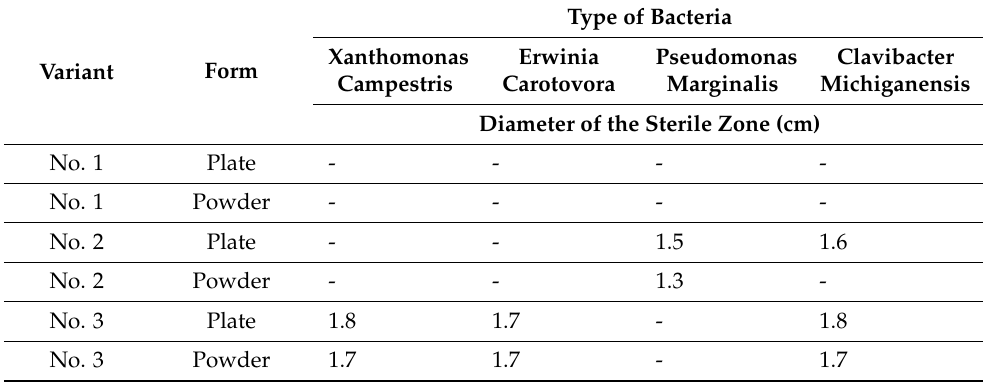
Figure 6. Samples of plates in bacterial suspensions (No. 1—316L; No. 2—316L +0.2 wt.% Ag; No. 3—316L +0.5 wt.% Ag). Table 2. Diameter of the sterile zone of the